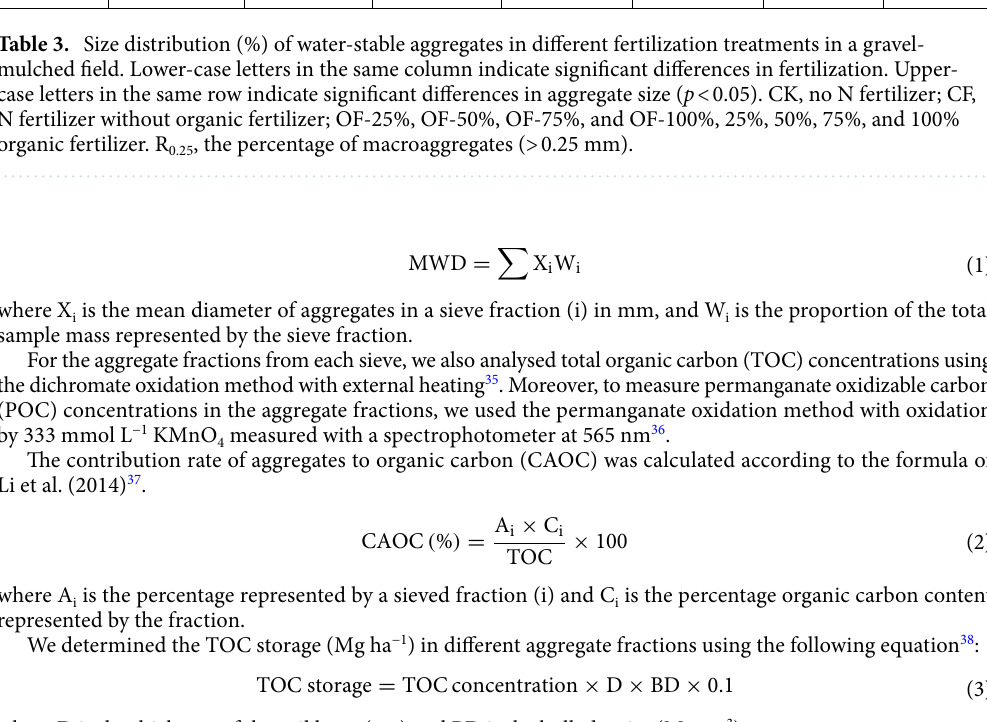
where D is the thickness of the soil layer (cm) and BD is the bulk density (Mg m −3 ).